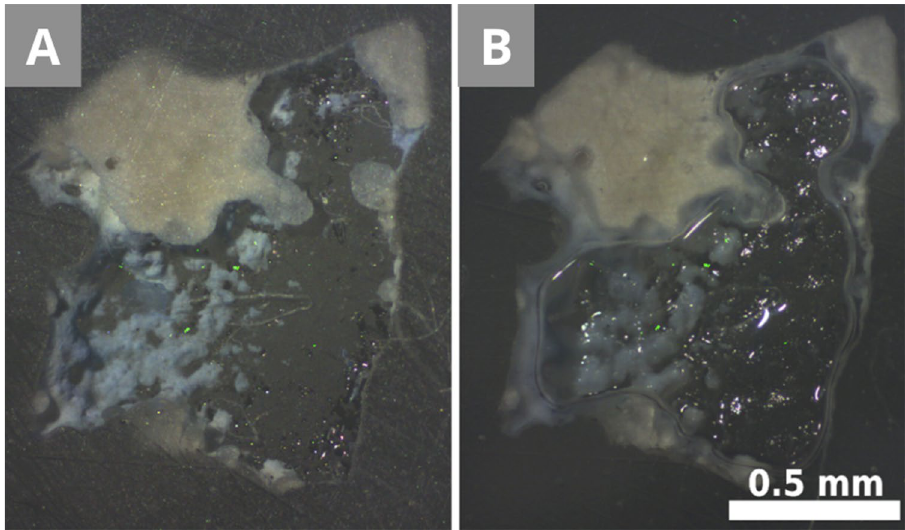
Figure 6. Unfixed sample MS1 that floated during the curing of the resin, and the parts of it removed during the polishing. (A) The scratches on the resin and the sample surface are visible. (B) Most scratches disappear thanks to the application of a drop of water and a coverslip over the sample, which creates an even surface.